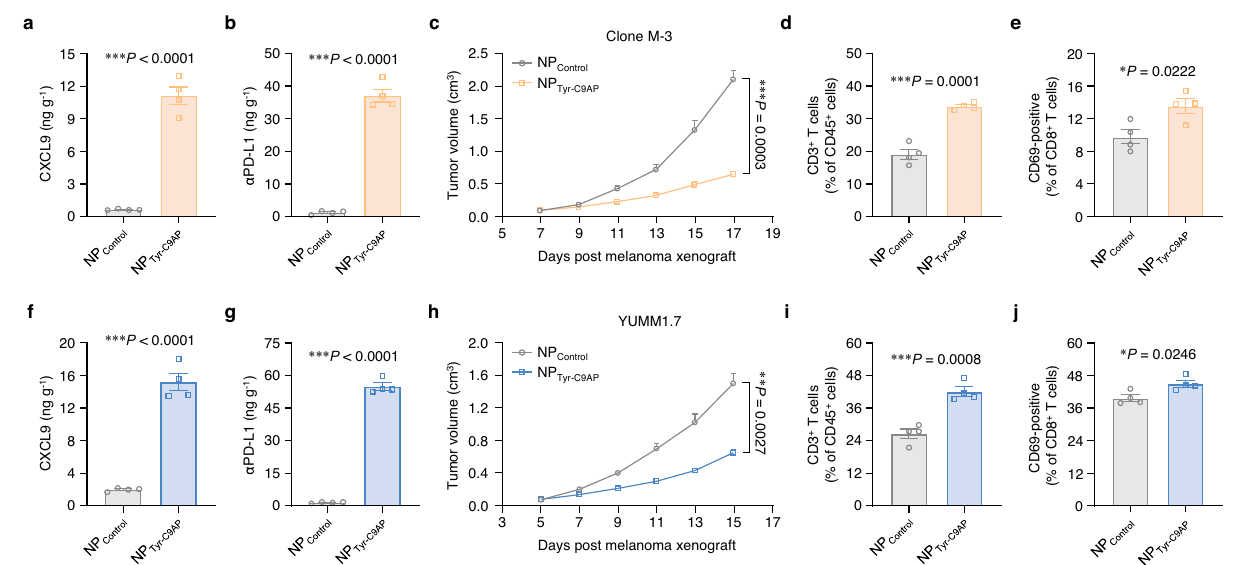
Fig. 7 | NP Tyr-C9AP induces enhanced therapeutic effects against different mel- anomas. a , b Concentrations ofCXCL9 ( a ) and α PD-L1 ( b ) in Clone M-3 melanoma after the i.v . injection of NP Tyr-C9AP or NP Control ( n =4 mice per group). c Tumor growth curves of the Clone M-3 melanoma-bearing mice treated with NP Tyr-C9AP or NP Control ( n =6 mice per group). d , e Percentages of CD3 + T cells ( d ) or CD69- positive CD8 + T cells ( e ) in Clone M-3 melanoma after the treatments. f , g ConcentrationsofCXCL9( f )and α PD-L1( g )inYUMM1.7melanomaafterthe i.v . injectionofNP Tyr-C9AP orNP Control ( n =4micepergroup). h Tumorgrowthcurvesof